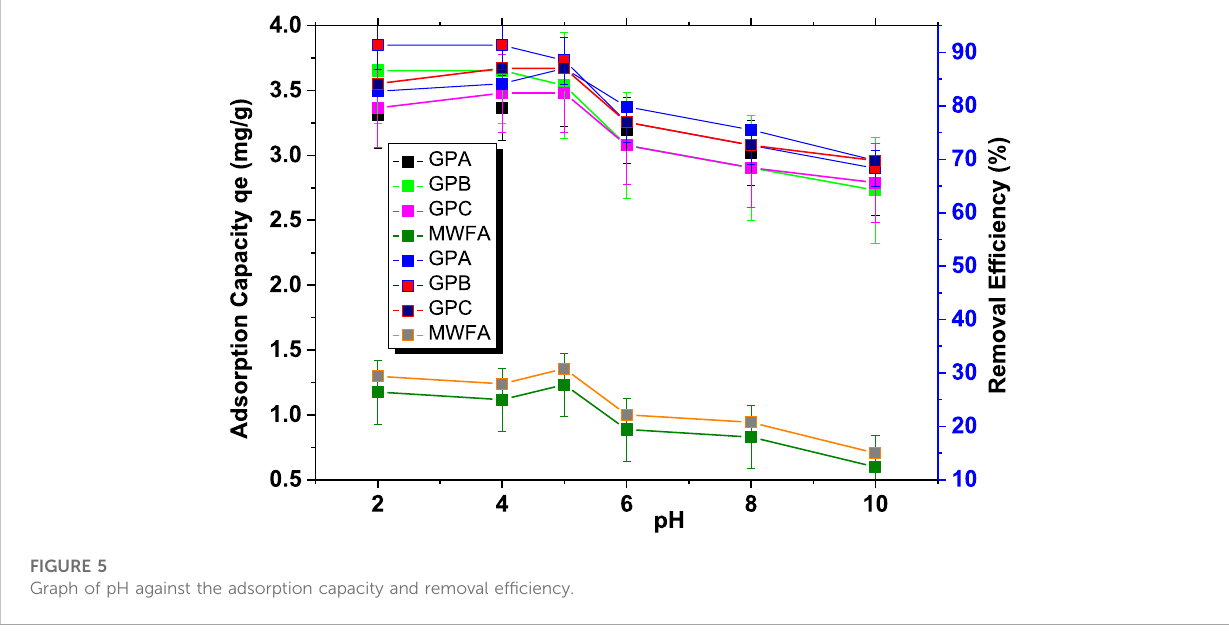
FIGURE 5 Graph of pH against the adsorption capacity and removal ef fi ciency.